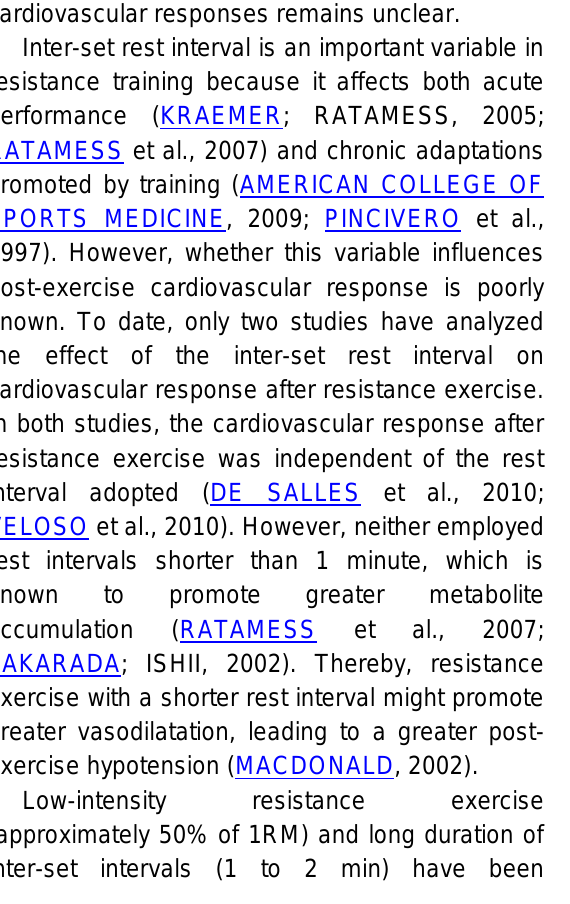
Table 1 . Baseline characteristics of the